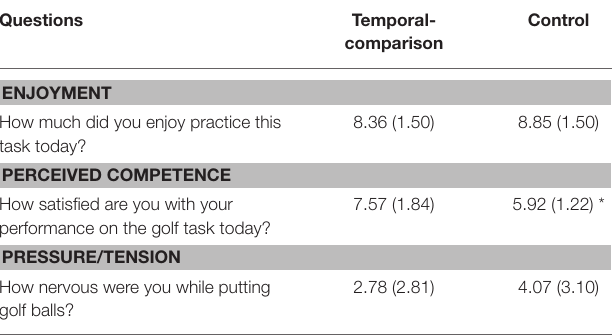
TABLE 1 | Results of the questionnaire completed at the end of practice (means and standard deviations). Responses for each question ranged from 0 (“not at all”) to 10 (“very”). Significant group differences are indicated by*.